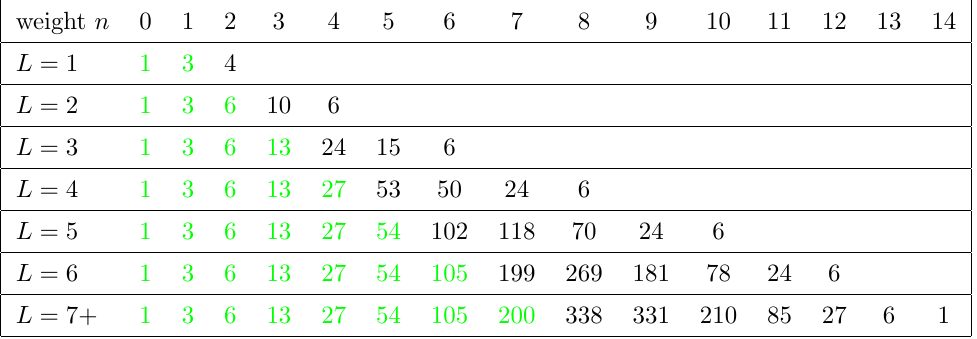
Table 4 . The number of independent f n; 1 ; 1 ; : : : ; 1 g coproducts of the MHV and NMHV amplitudes through L = 6 loops. A green number denotes saturation. The (cid:12)nal line gives the number using all known loop orders together, including 7 loop